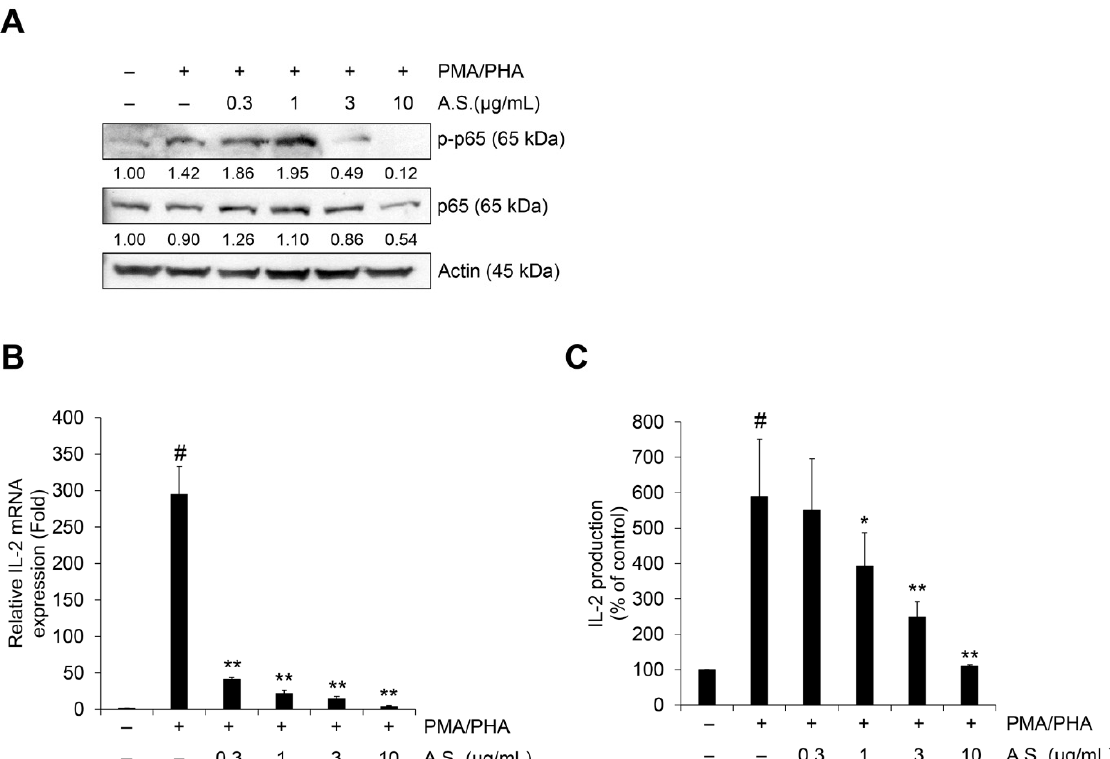
Figure 4. A.S. extract inhibits NF- κ B signaling mediated IL-2 expression in T-ALL Jurkat cells. Jurkat cells were treated with A.S. extract phorbol 12-myristate 13-acetate (PMA) (50 ng/mL) plus phytohaemagglutinin (PHA) (1 µ g/mL) together for 6 ( A ), 3 ( B ), or 24 h ( C ). ( A ) Expressions of p65 and its phosphorylated form were measured by Western blot, with actin as